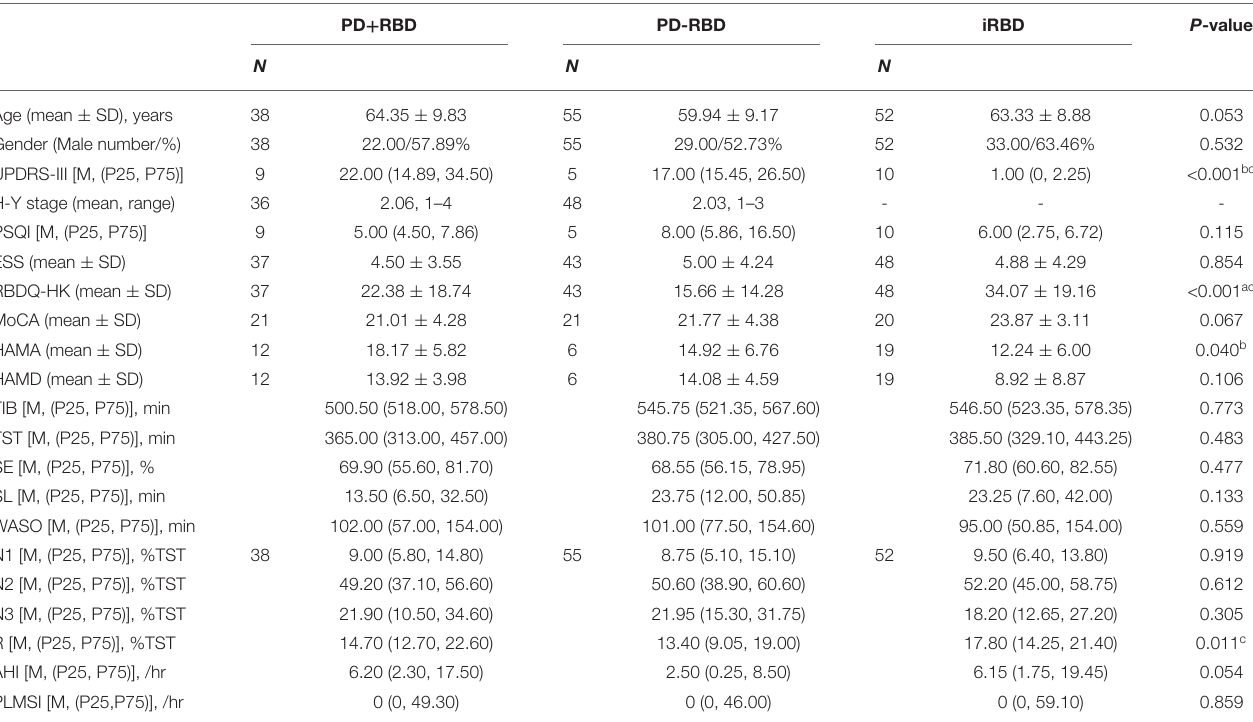
TABLE 1 | Demographics and clinical tests including Unified Parkinson’s Disease Rating Scale part III (UPDRS-III) and Hoehn-Yahr (H-Y) stage scores, Pittsburgh sleep quality index (PSQI), Epworth sleepiness scale (ESS), REM Sleep Behavior Disorder Questionnaire-Hong Kong (RBDQ-HK), Montreal Cognitive Assessment (MoCA), Hamilton rating scale for anxiety (HAMA), Hamilton rating scale for depression (HAMD) in Parkinson’s disease (PD), isolated rapid eye movement sleep behavior disorder (iRBD) and PD with RBD subjects. PD +